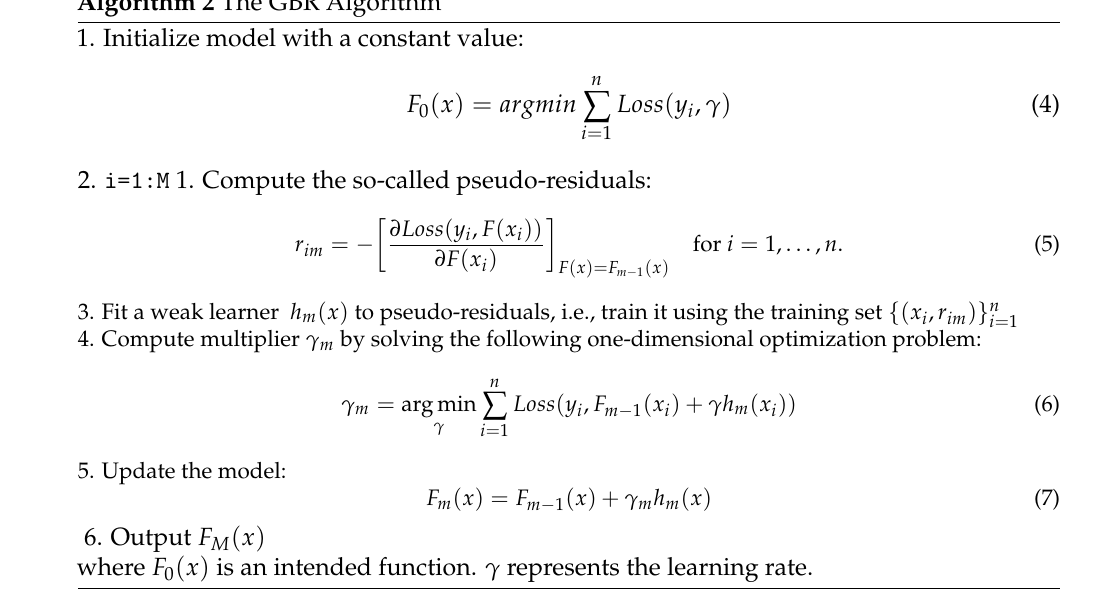
Algorithm 2 The GBR